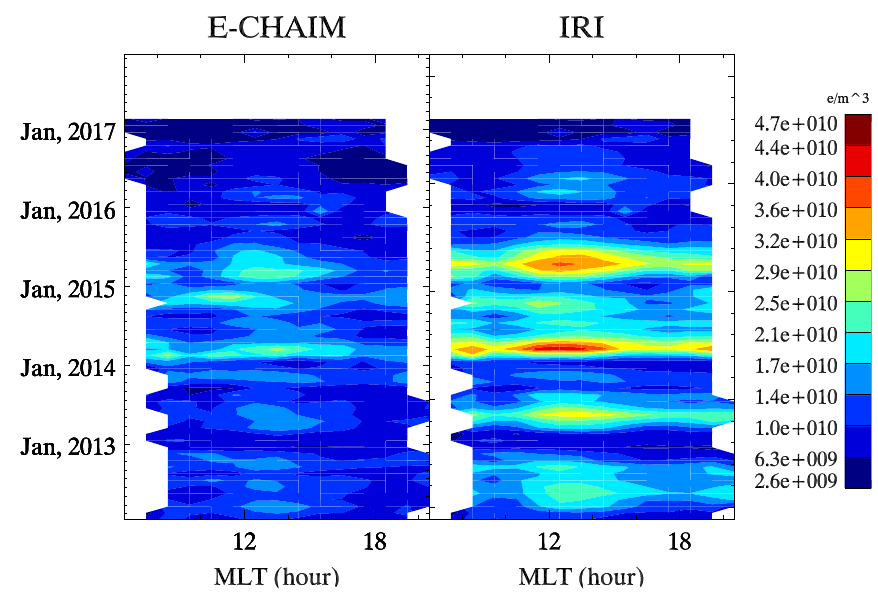
Fig. 11. Same as Figure 10 but for DMSP satellite F18.